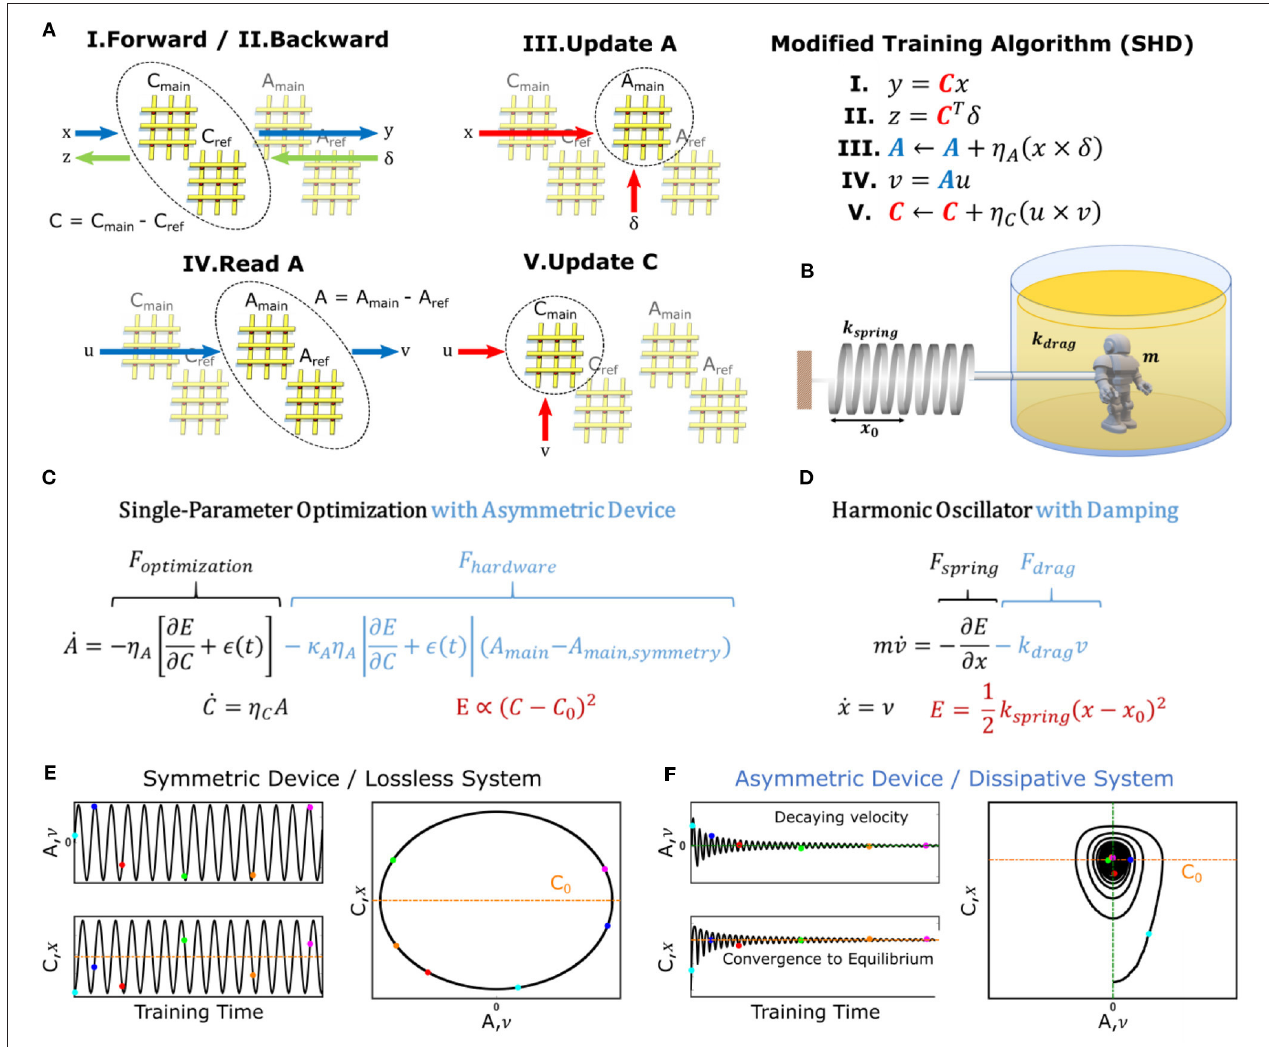
FIGURE 2 | DNN training with Stochastic Hamiltonian Descent (SHD) algorithm and dynamics of a dissipative harmonic oscillator. (A) Schematic and pseudocode of training process using the SHD algorithm. The pseudocode only describes operations computed in the analog domain, whereas digital computations such as non-linear error functions are not shown for simplicity. (B) Illustration of a damped harmonic oscillator system. (C) Differential equations describing the evolution of the parameters with the SHD training algorithm in the continuum limit. (D) Equations of motion describing the dynamics of a harmonic oscillator. (E) Simulated results for a single-parameter optimization task using the SHD algorithm with symmetric devices described in Figure 1B . (F) Simulated results for a single-parameter optimization task using the SHD algorithm with asymmetric devices described in Figure 1E